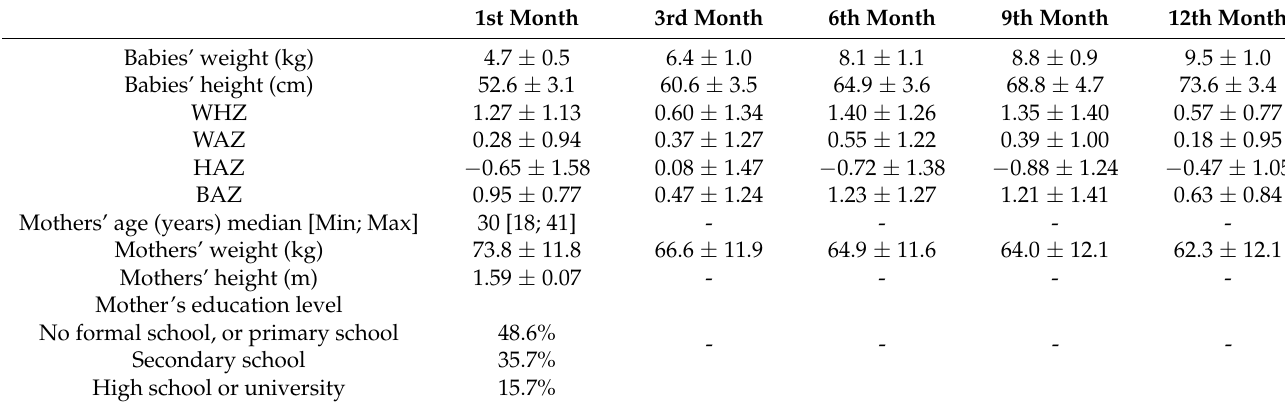
Table 1. Characteristics of infants and mothers according to baby’s age.